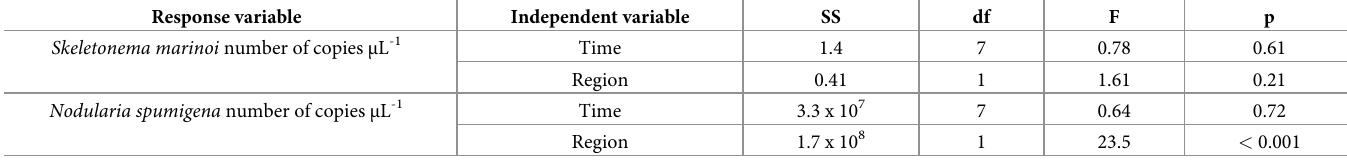
Table 1. Differences in phytoplankton detection in Macoma balthica by qPCR. Response